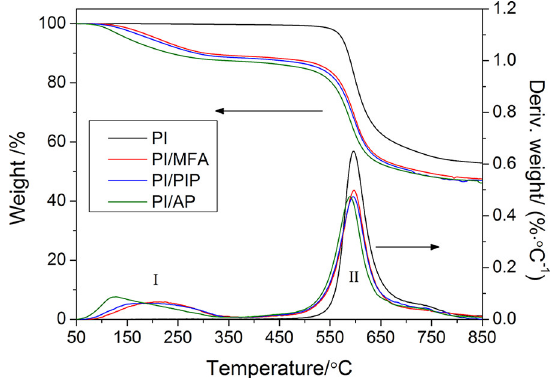
Figure 2. Curves of thermal gravimetric analysis and differential thermal analysis for PI fibers treated with swelling agents (I: the first peak at DTG curve, II: the second peak at DTG curve).